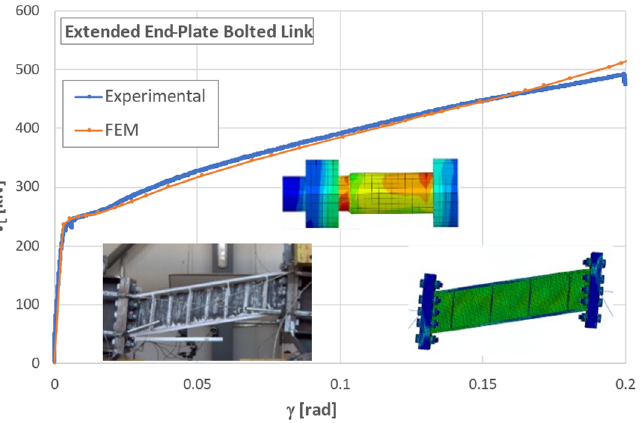
Figure 12. Comparison between experimental and FEM monotonic test of an extended end plate bolted link.